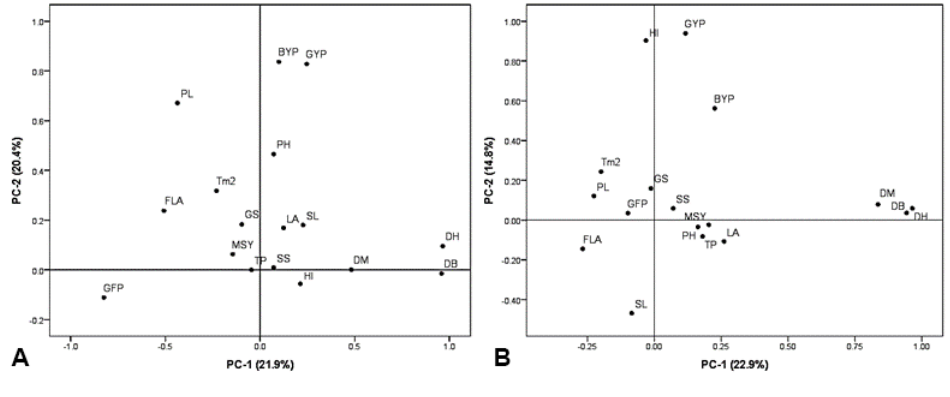
Figure 3 PCA analysis of agronomic traits of different wheat genotypes in ( A ) moisture stress (MS) or ( B ) well-watered (WW)